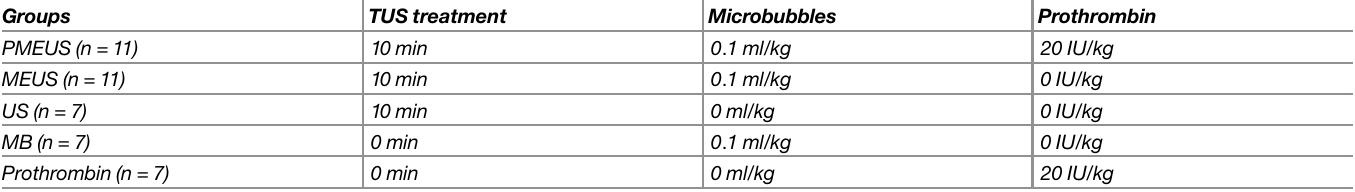
Table 1. Animal group assignments and treatment